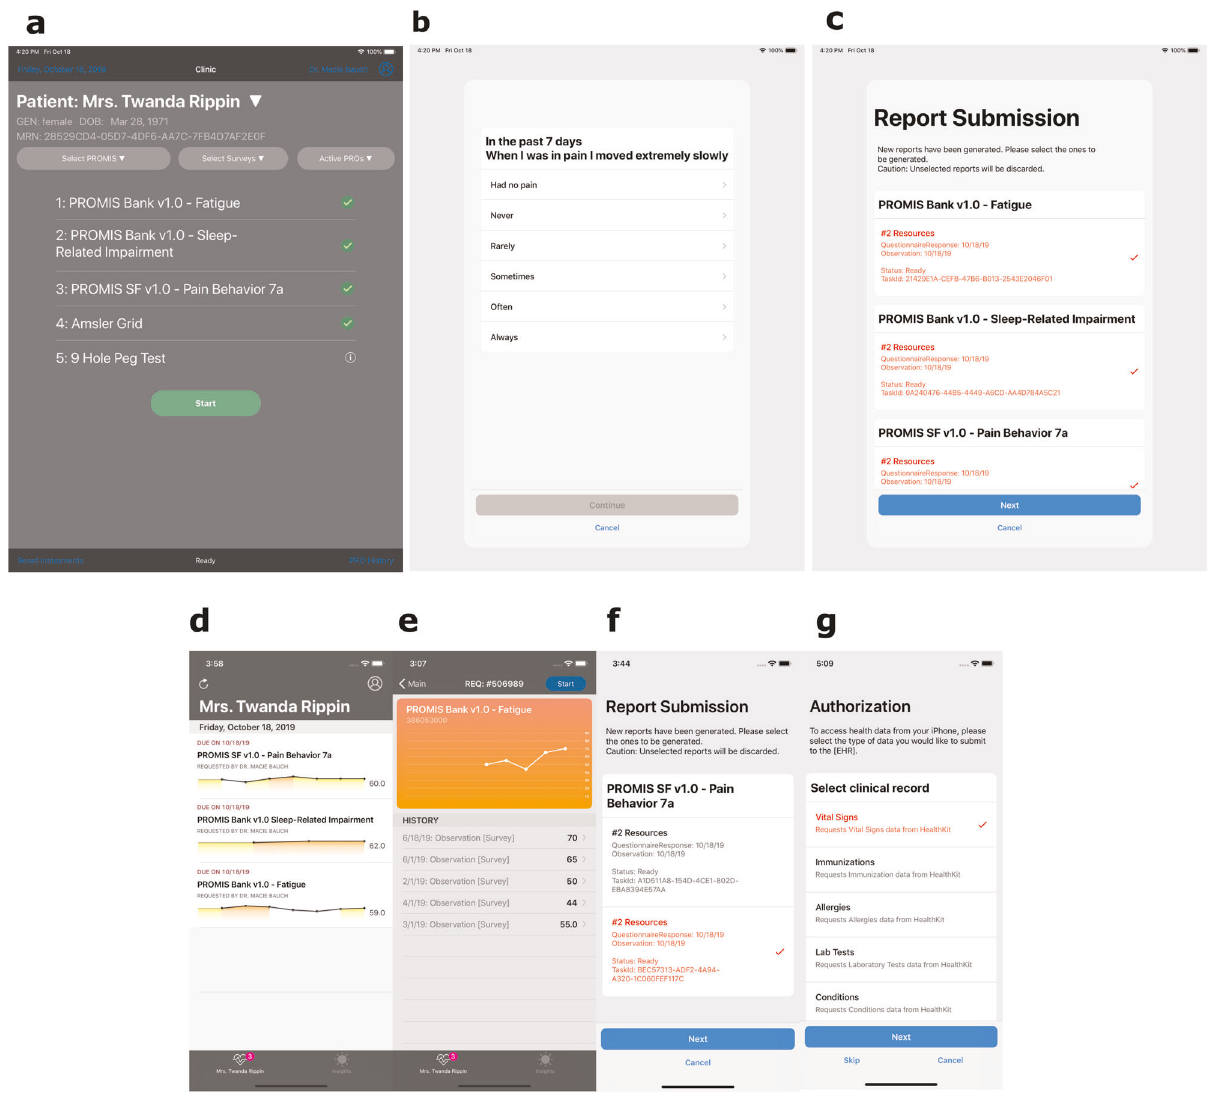
Fig. 6 PGHD application screenshots. Practitioner-facing app a dashboard view for PGHD selection. b PROMIS session rendered by ResearchKit. c PGHD report submission step. Patient-app d main view listing all requests. e Visualization of historical record. f Report submission step. g Apple Health FHIR data capturing task